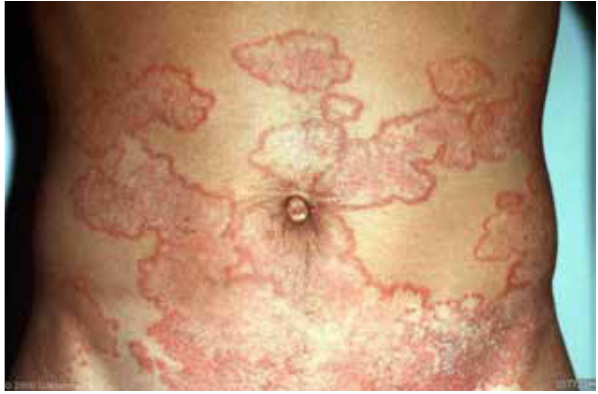
Figure 2. Tinea corporis of the trunk (Image available from https://www.dermquest.com/image-library/